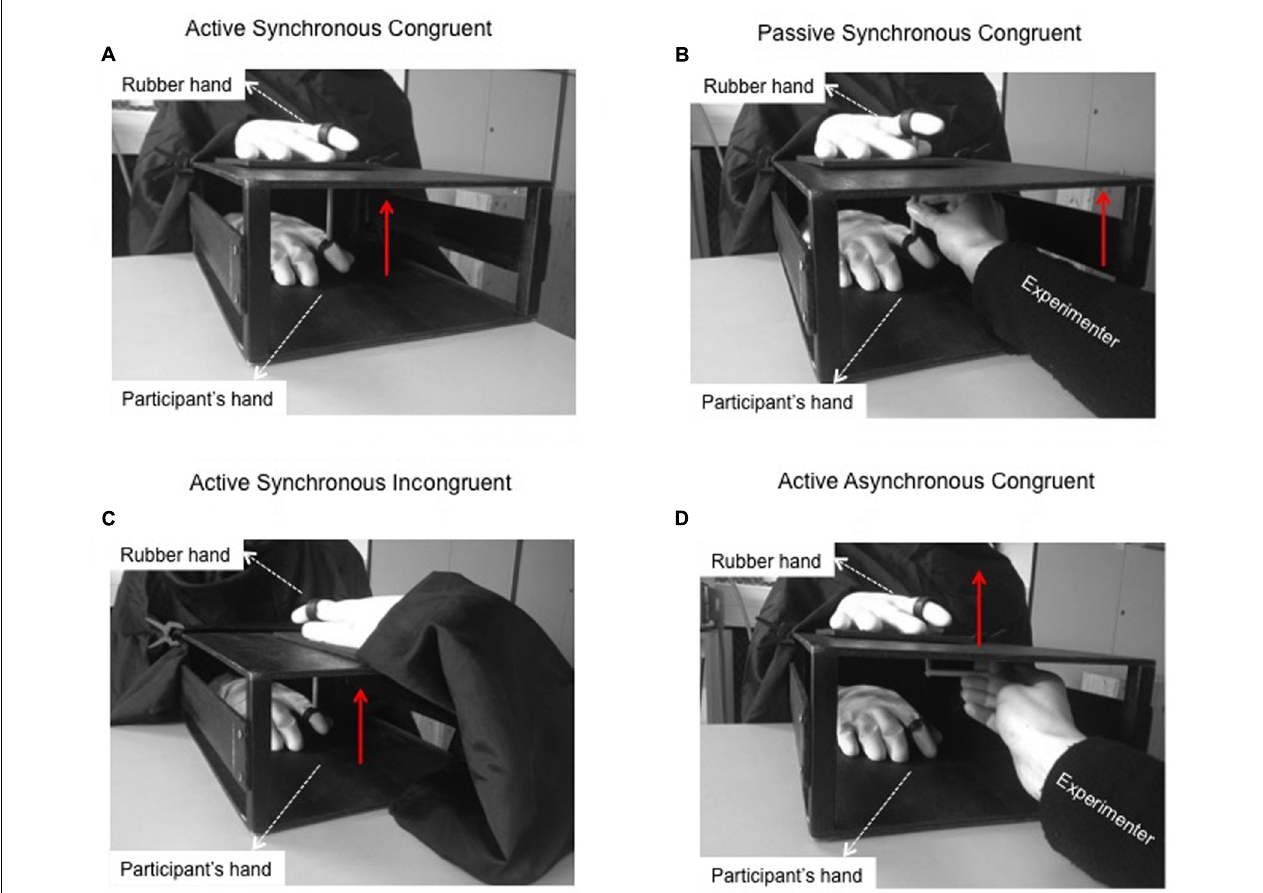
FIGURE 1 | Moving Rubber Hand Illusion apparatus. (A) In the Active Synchronous Congruent condition, when the participant actively moved her own index finger, the rubber hand moved in turn. This condition usually evokes the sense of agency and the sense of ownership over the rubber hand. The red arrow indicates the direction of the movement. (B) In the Passive Synchronous Congruent condition, the experimenter moved a wooden stick, thus causing both the participant’s hand and the rubber hand to move. This condition usually induces ownership but not agency over the rubber hand. (C) In the Active Synchronous Incongruent condition, the rubber hand was rotated of 180 degrees with respect to the participant’s hand. The participant moved her index finger and the rubber hand moved synchronously. This condition usually evokes agency but not ownership over the rubber hand. (D) In the Active Asynchronous Congruent condition, the rubber hand was placed in an anatomically congruent position and the participant performed active movements as in the Active Synchronous Congruent condition. In this case, however, the rubber hand was moved by the experimenter with a short delay with respect to the onset of the participant’s movement. This condition does not evoke sense of agency or sense of body